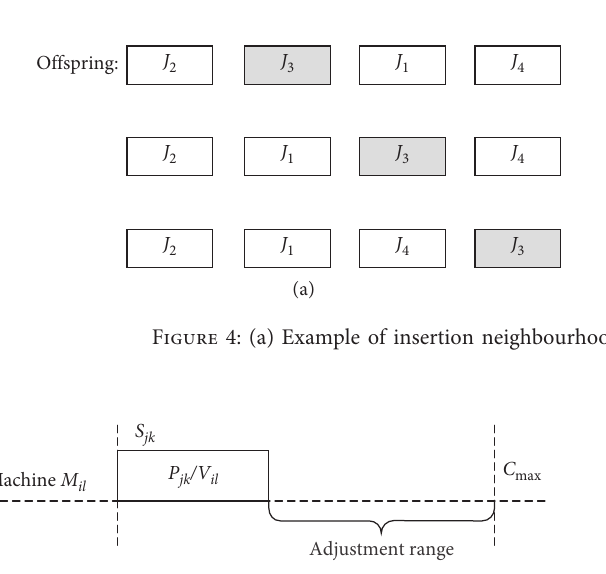
Figure 5: Adjustment diagram when O machine M il and k � N j .